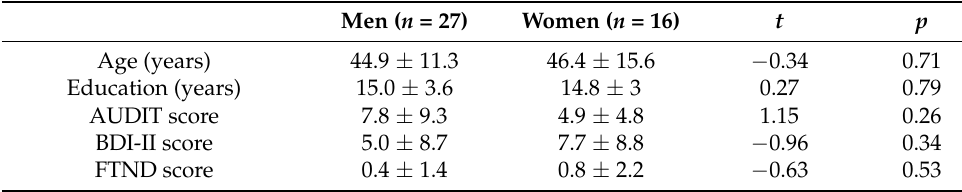
Table 1. Demographic and clinical characteristics in men and